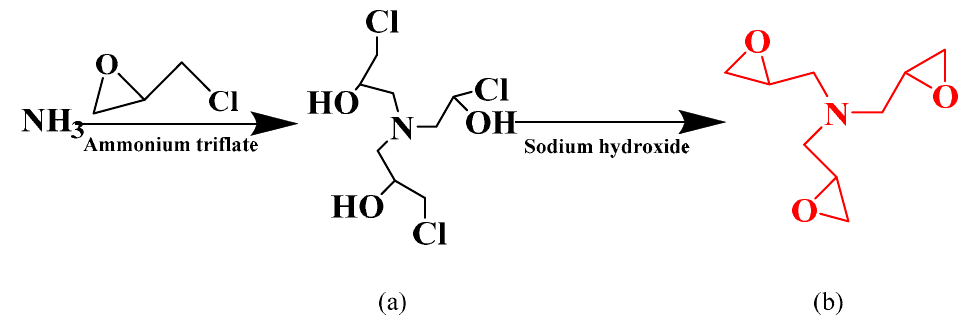
Figure 1. Figure 1. The synthesis procedure for triglycidylamine and its chemical structure. ( a ) tris(3 ‐ chloro ‐ 2 ‐ hydroxypropyl) amine; ( b ) TGA.